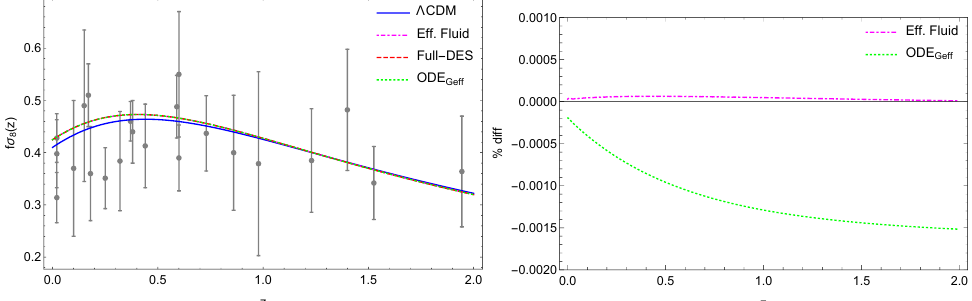
Figure 2. ( Left ) The theoretical predictions for the f σ 8 ( z ) parameter of the HDES model with n = 2, − 2 and σ ˜ J = 0.8 versus the f σ c = 5 · 10 8,0 8 data compilation from Ref. [112]. ( Right ) The percent difference between the “Full-DES" brute-force numerical solution and the effective fluid approach (magenta dot dashed line) and the numerical solution of the growth factor equation (39) (green dotted line). Image from Ref.